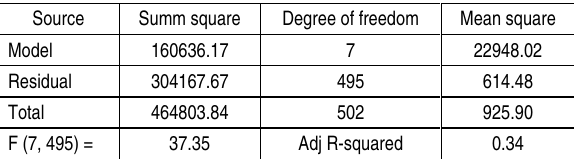
Table 6. Model fit indicator